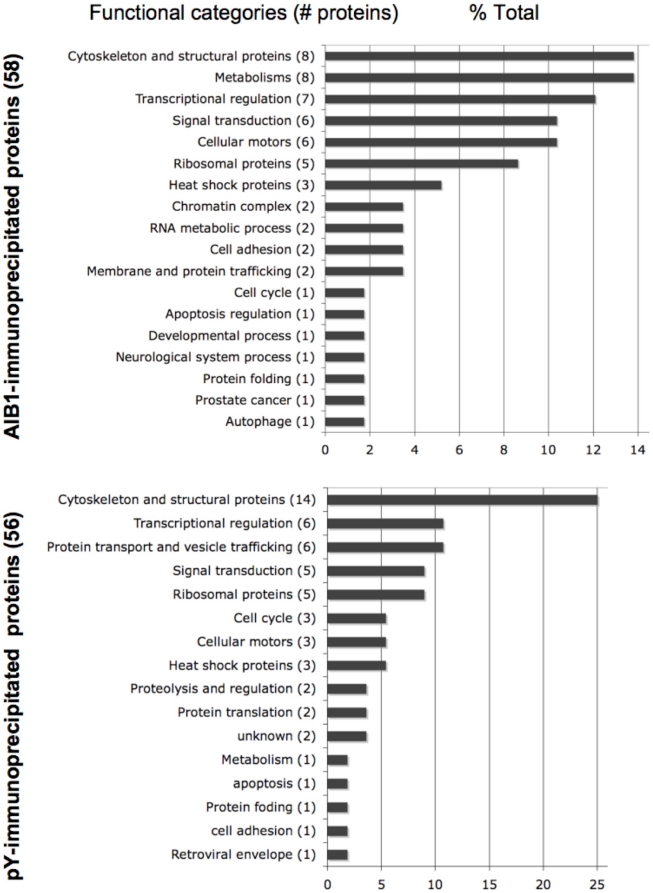
Functional categories of anti-AIB1 (upper) and anti-pY immunoprecipitated proteins (lower) from MCF-7 and MCF-7:5C breast cancer cells.Numbers in parenthesis are the number of proteins belonging to the respective category. Proteins profiled are those with CI values ≥95% from mass spectrometry.